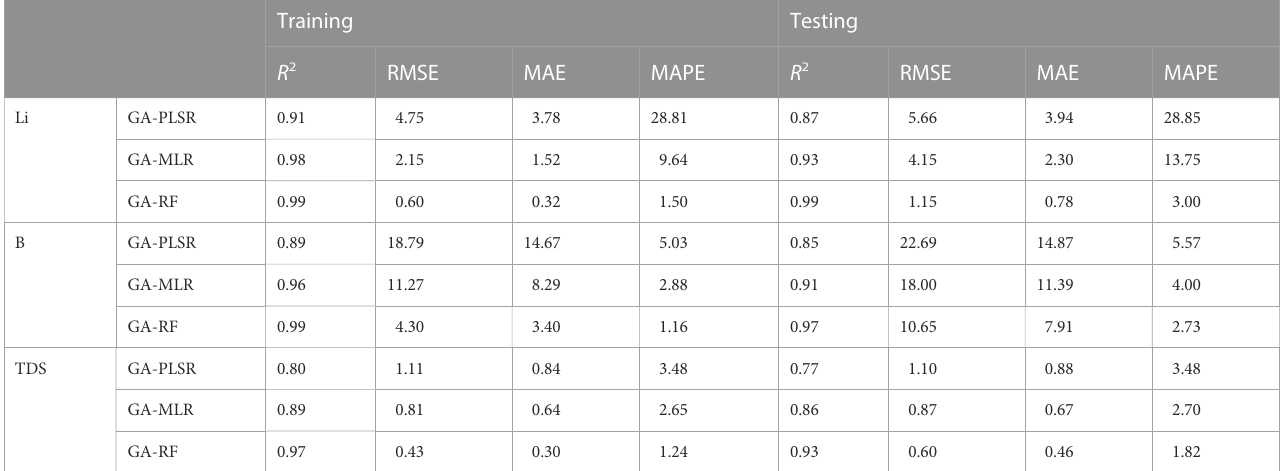
TABLE 3 Performance of the estimation model based on the feature selection method. Training